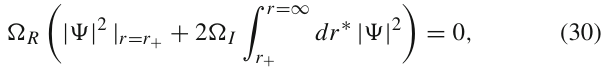
points, marked by B , and eventually terminate on the criti- cal line with zero a H . For a multiphase system in a